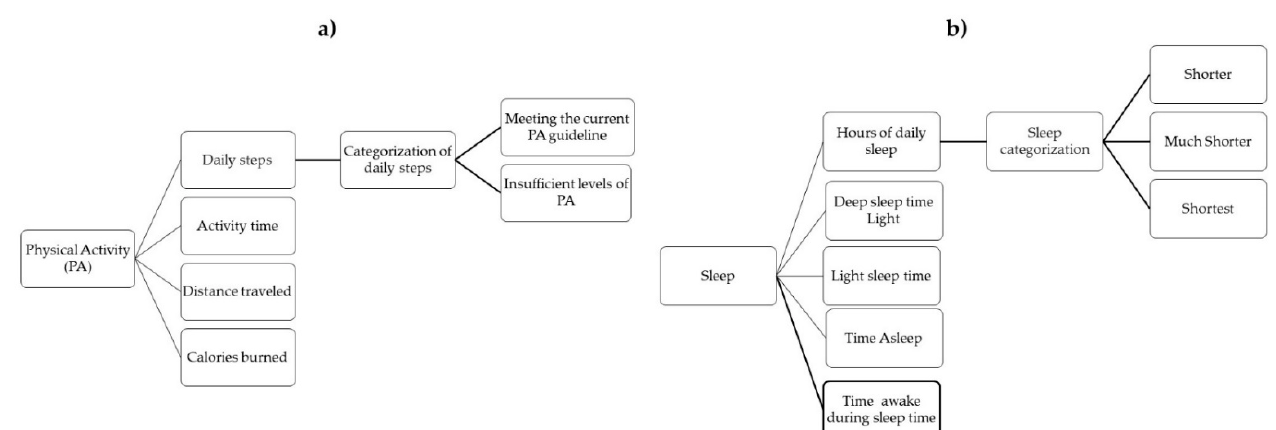
Figure 2. Kinds of data obtained by non-intrusive device: ( a ) Data of physical activity and ( b ) hours of sleep.